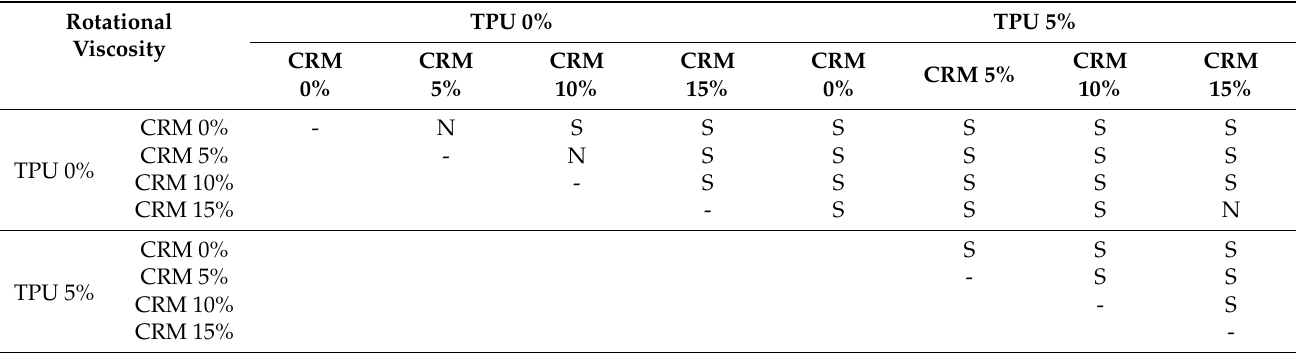
Figure 5. Viscosity of the asphalt binder containing CRM and TPU at 135 ◦ C. Table 4. Statistical analysis results of the viscosity as a function of CRM contents and the addition of TPU ( α =